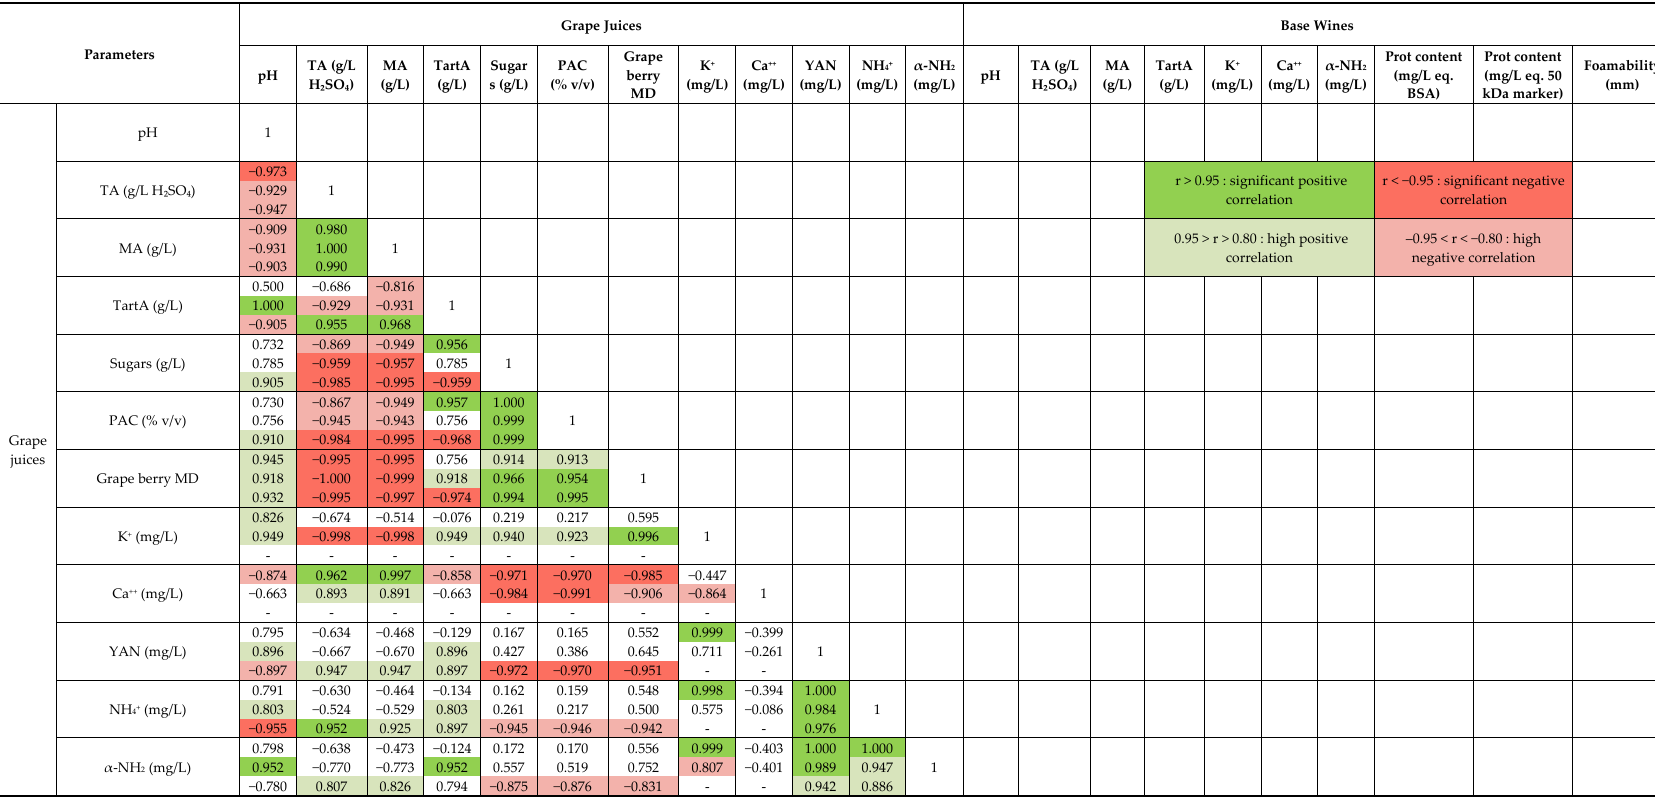
Molecules 2018 , 23 , x FOR PEER REVIEW 10 of 23 Table 4. Pearson test correlation coefficients ( r ) among the oenological parameters of Chardonnay grape juices and base wines ( p < 0.05).